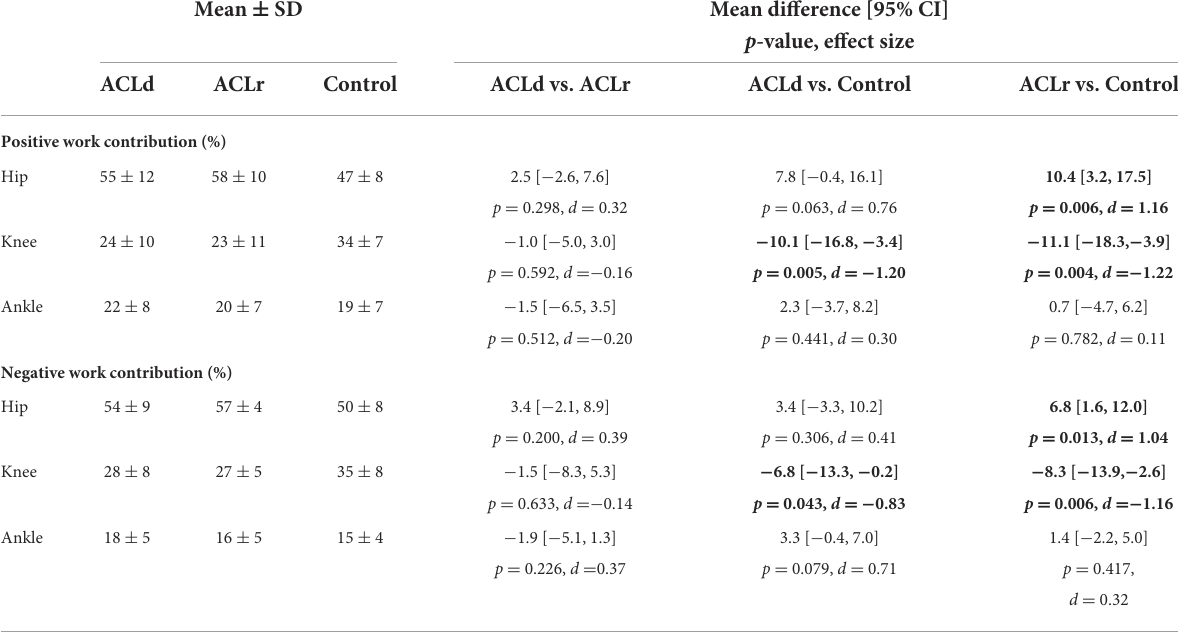
TABLE 3 Joint contributions to total work performed during the forward lunge in patients with an ACL injury and healthy controls. Mean ± SD Mean difference [95% CI] p -value, effect size ACLd ACLr Control ACLd vs. ACLr ACLd vs. Control ACLr vs.